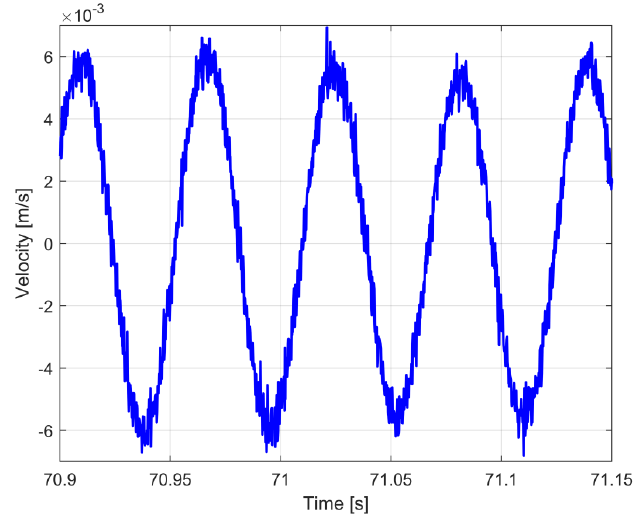
Figure 4. A zoomed-in detail of Figure 3 in the area labelled as A.